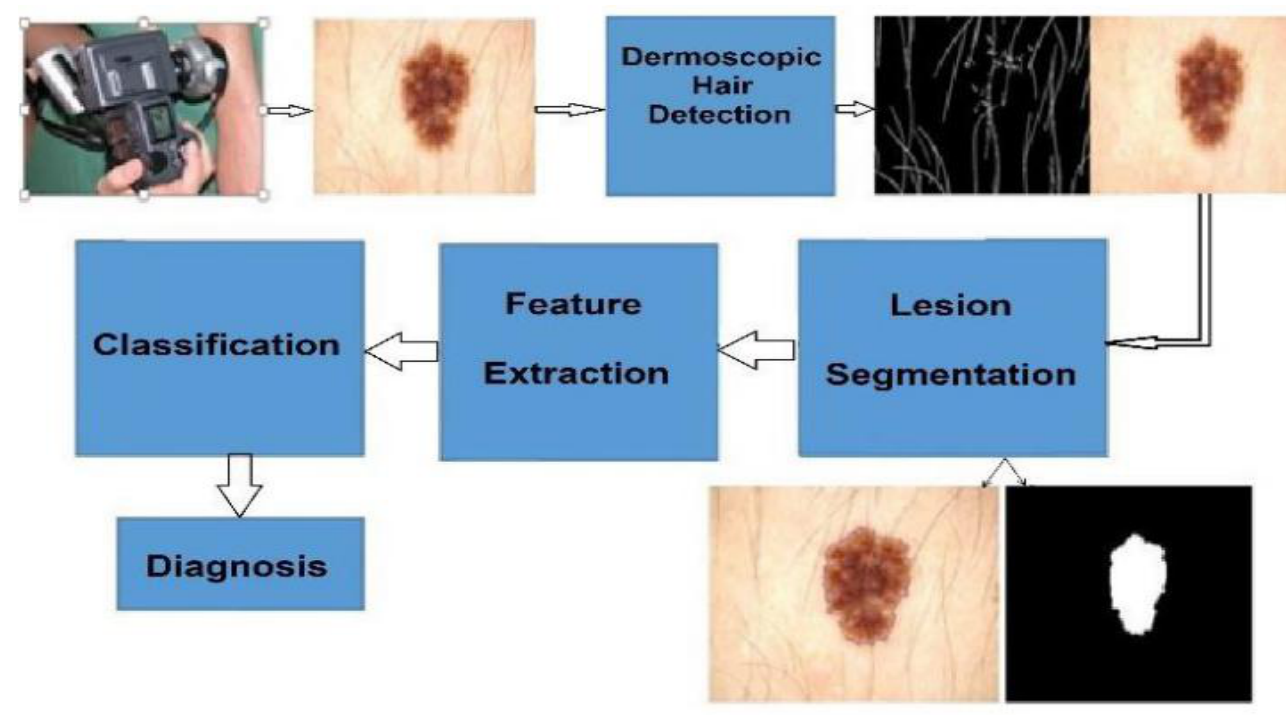
Figure 3. A flowchart illustrating the proposed machine learning system for detecting skin cancers using dermoscopic images.